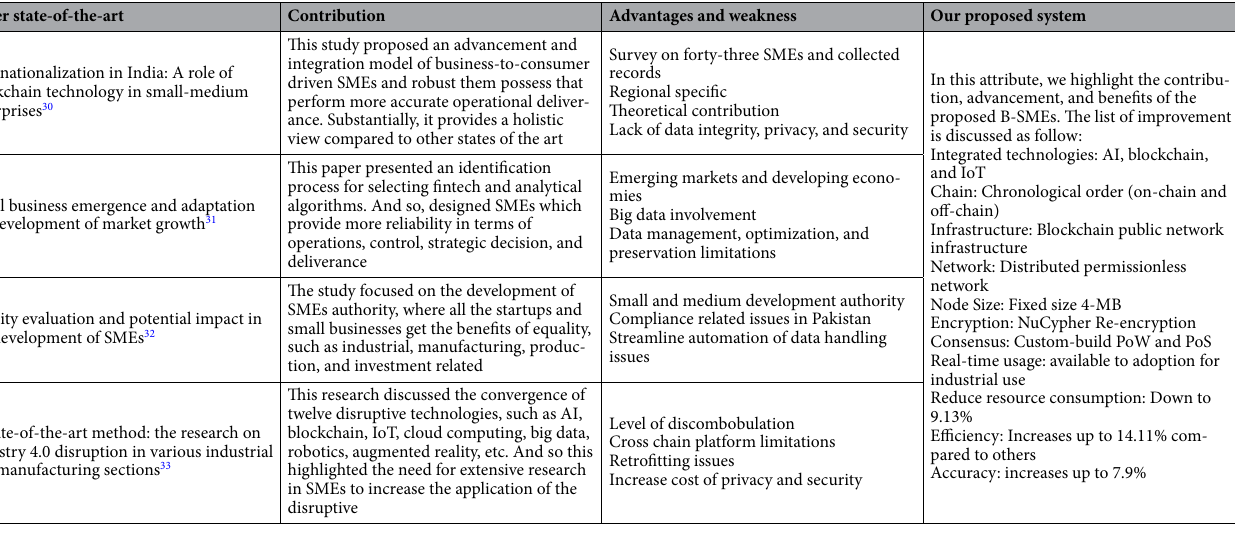
Table 4. Comparison with other state-of-the-art